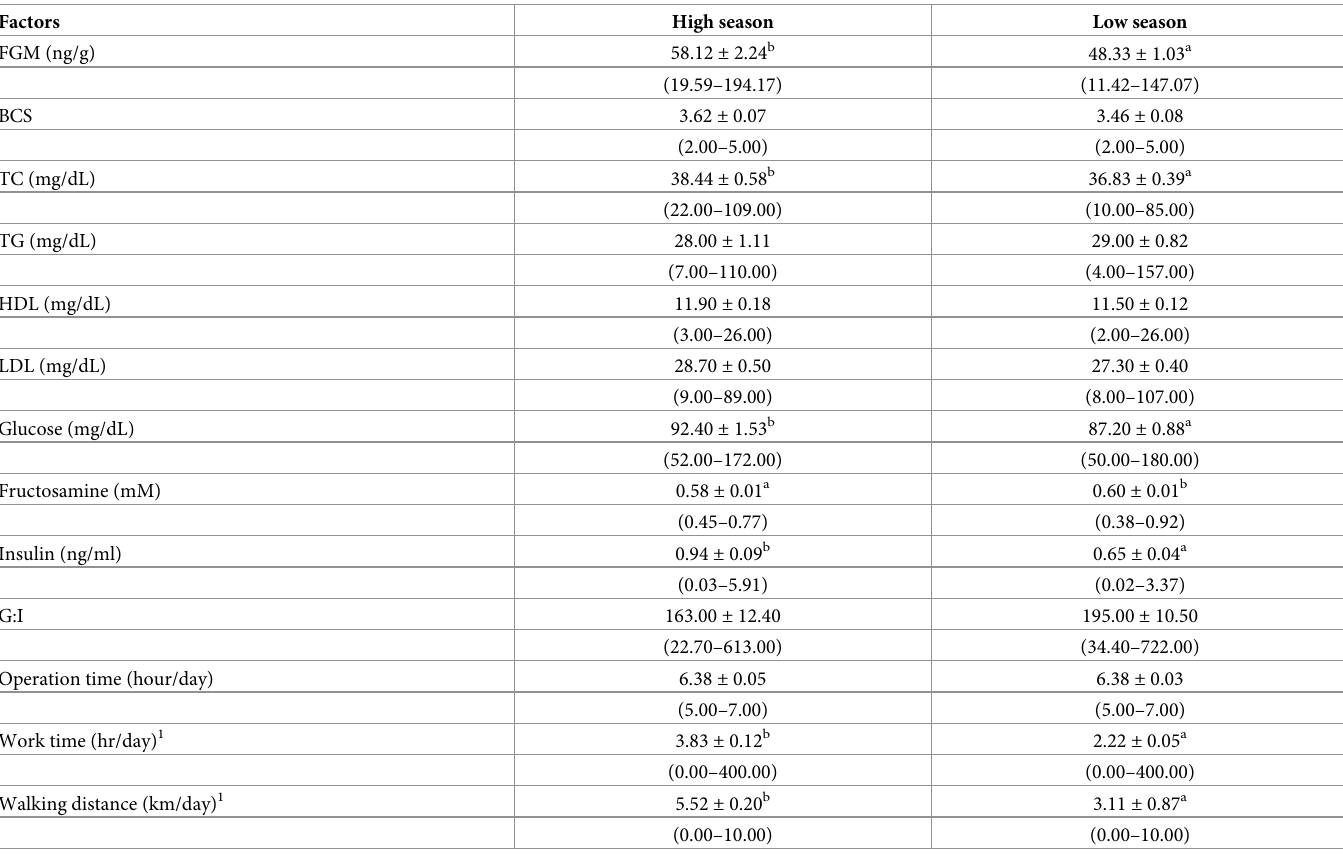
Table 3. Differences in FGM, metabolic and lipid measures in captive elephants evaluated during the High and Low tourist season. Mean ( ± SEM) and range values (min–max) are presented. Fecal samples were collected for glucocorticoid analyses, and visual body condition scores were determined based on a set of photographs. Blood samples were collected to assess lipid and metabolic status. The elephants were housed at five elephant camps in Northern Thailand with different tourist